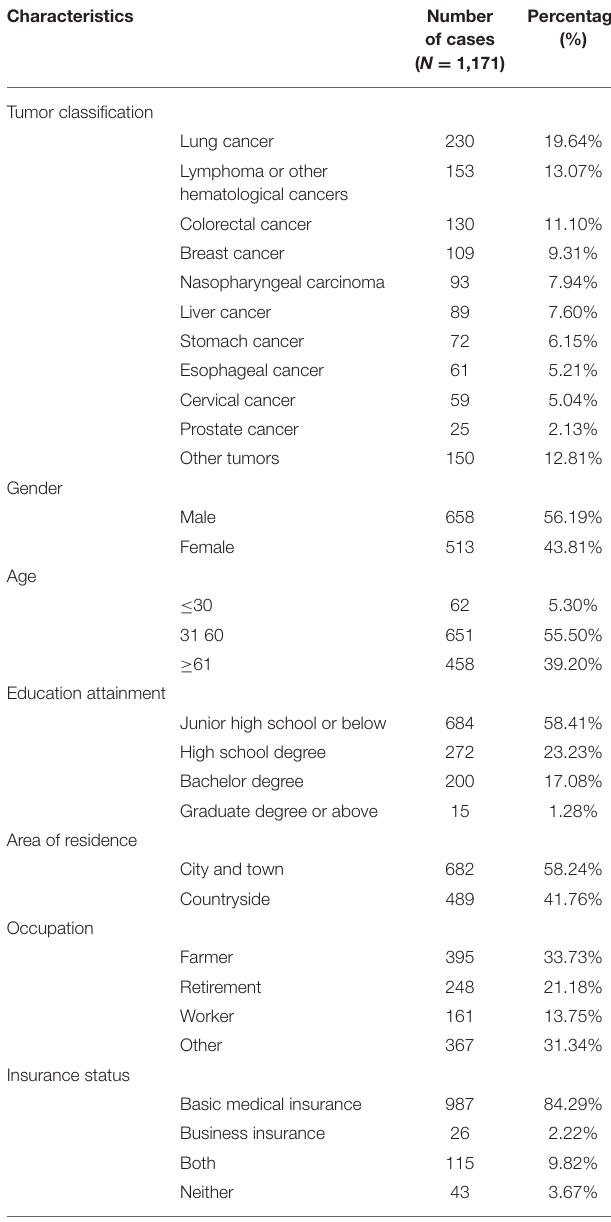
TABLE 1 | Demographic